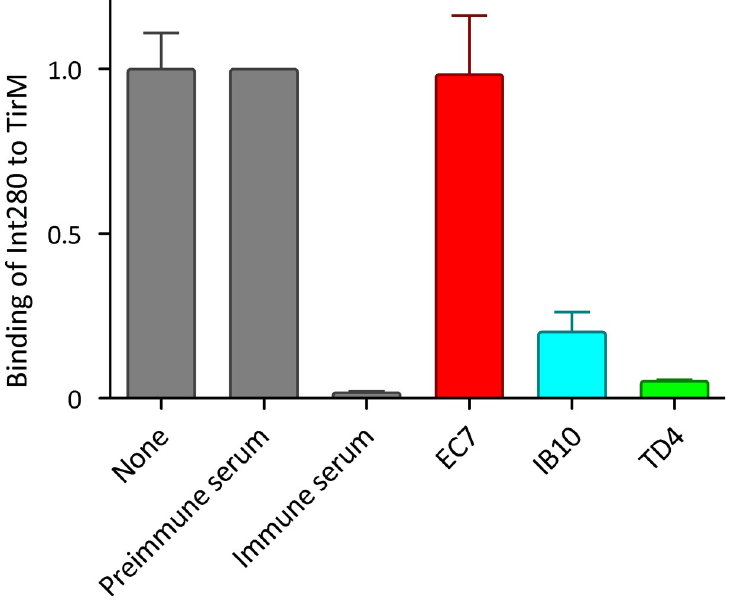
Fig 4. Competition of purified Nbs for TirM binding in the presence of Int280. Representation of the binding signals obtained from Int280-TirM interaction ELISA in the presence of PBS (none), the indicated camel sera or purified Nbs (EC7, IB10 and TD4). ELISA plates were coated with 5 μ g/ml TirM EHEC or BSA control and incubated with 50 μ g/ml biotinylated Int280 EHEC in the presence of camel pre-immune and immune sera (1:50 dilution), 50 μ g/ ml purified Nbs (EC7, IB10, TD4) or PBS control. Binding of biotinylated Int280 was evaluated by incubation with Streptavidin-POD and measurement of OD490. Data are presented as means and standard deviations from of two independent experiments with triplicates. Values are indicated relative to those of Int280-TirM interaction in the presence of PBS.